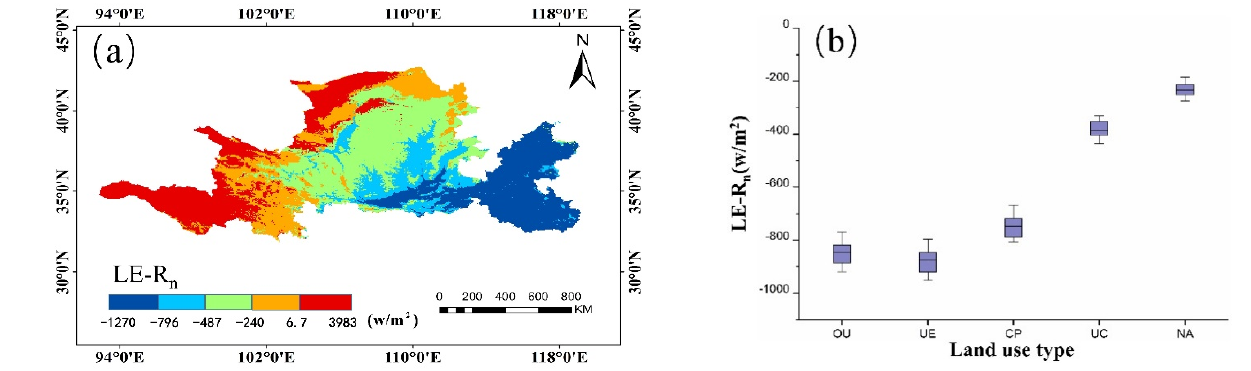
Figure 11. ( a ) Spatial variation (LE − R n ) and ( b ) statistical values for the five land use types in the influence area of the YRB from 2000 to 2015.